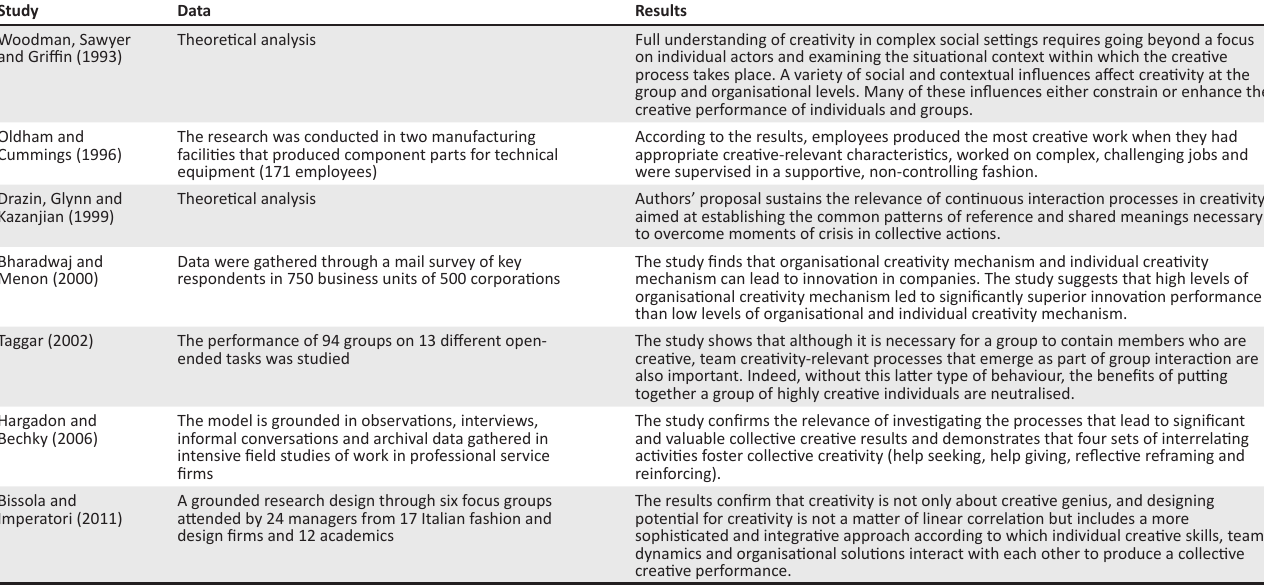
TABLE 1: Literature on collective